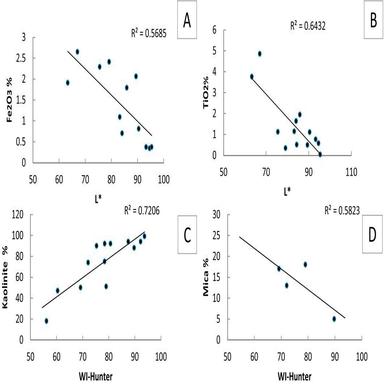
Possible correlations between color parameters and composition of the samples (mineralogy and chemistry).